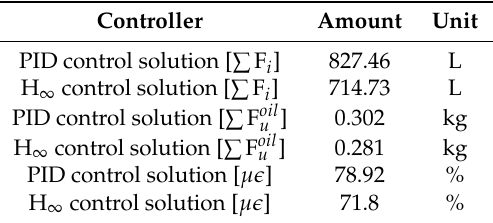
Figure 3. Experiment Results: controller evaluation with fluctuating inlet flow rate F i . This plot shows the total oil discharged through the underflow. Table 4. Total volume of the inlet mixture, total volume of oil discharged, and mean de-oiling efficiency (cid:101) . In the experiment (controller evaluation with fluctuating inlet flow rate F i ), the duration was 1900